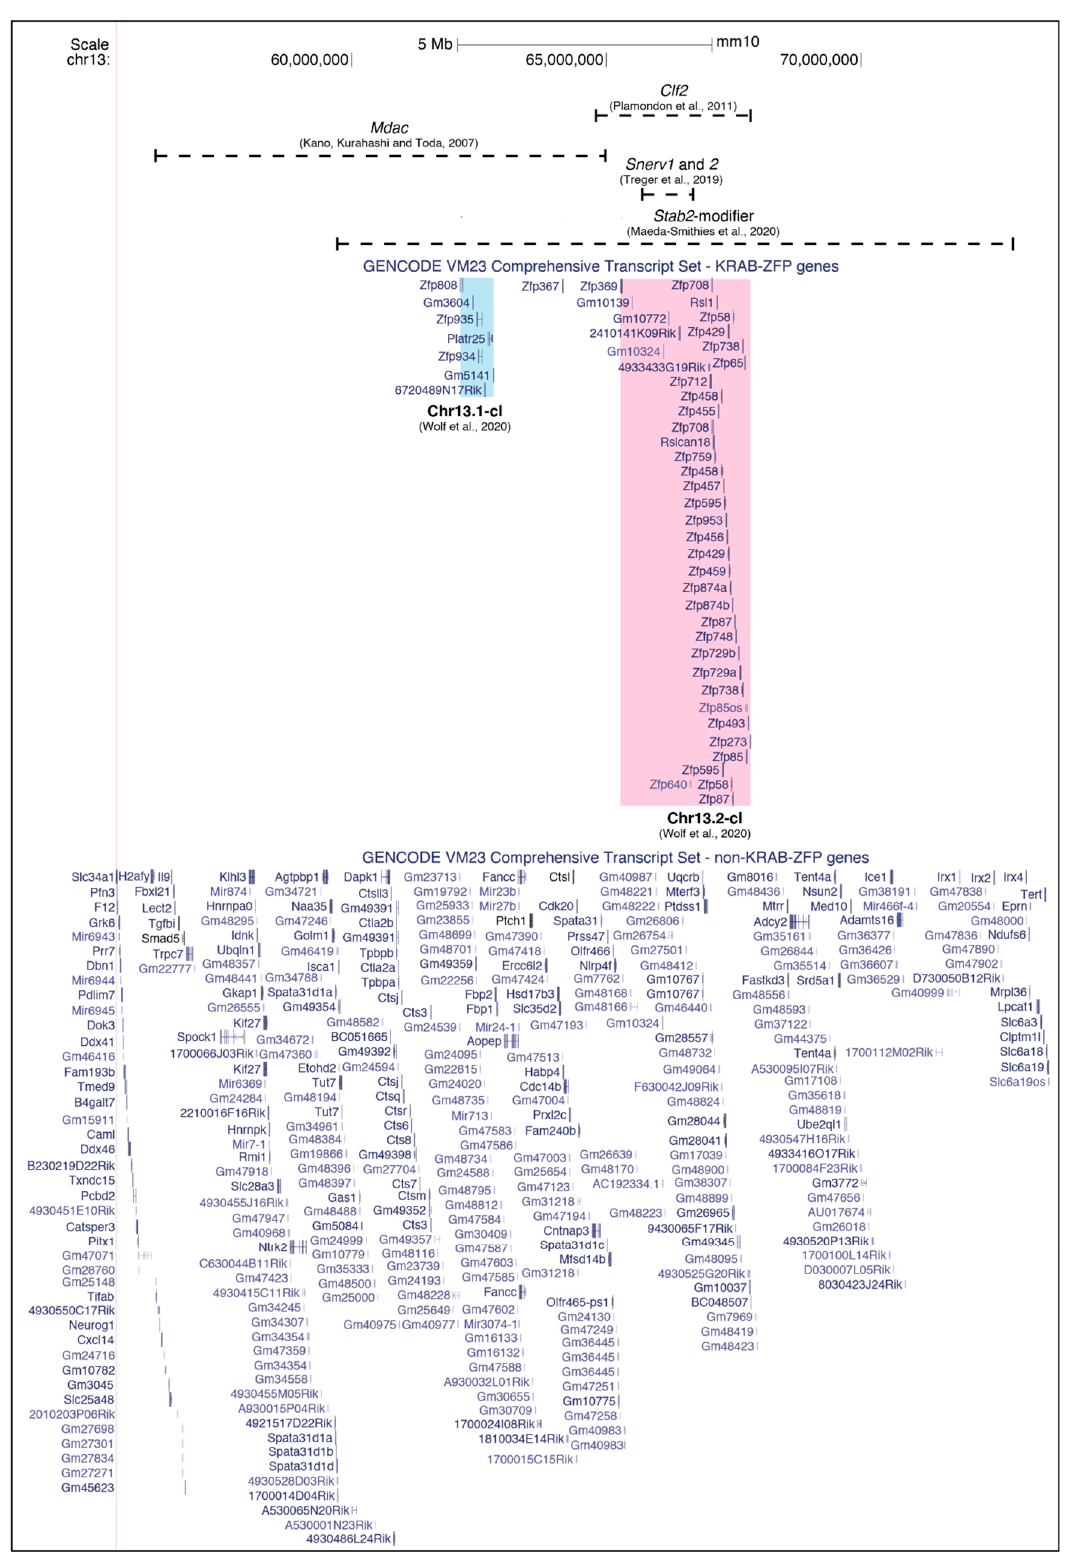
Figure 2. The mapped intervals of four strain-specific ERV modifiers— Mdac , Clf2 , Snerv1 and Snerv2 and Stab2-modifier —on Chromosome 13. The underlying genes are separated into Krüppel-associated box domain zinc-finger protein (KRAB-ZFP) genes and non-KRAB-ZFP genes; the KRAB-ZFP clusters are highlighted and named as in [59]. Multiple isoforms are not shown.